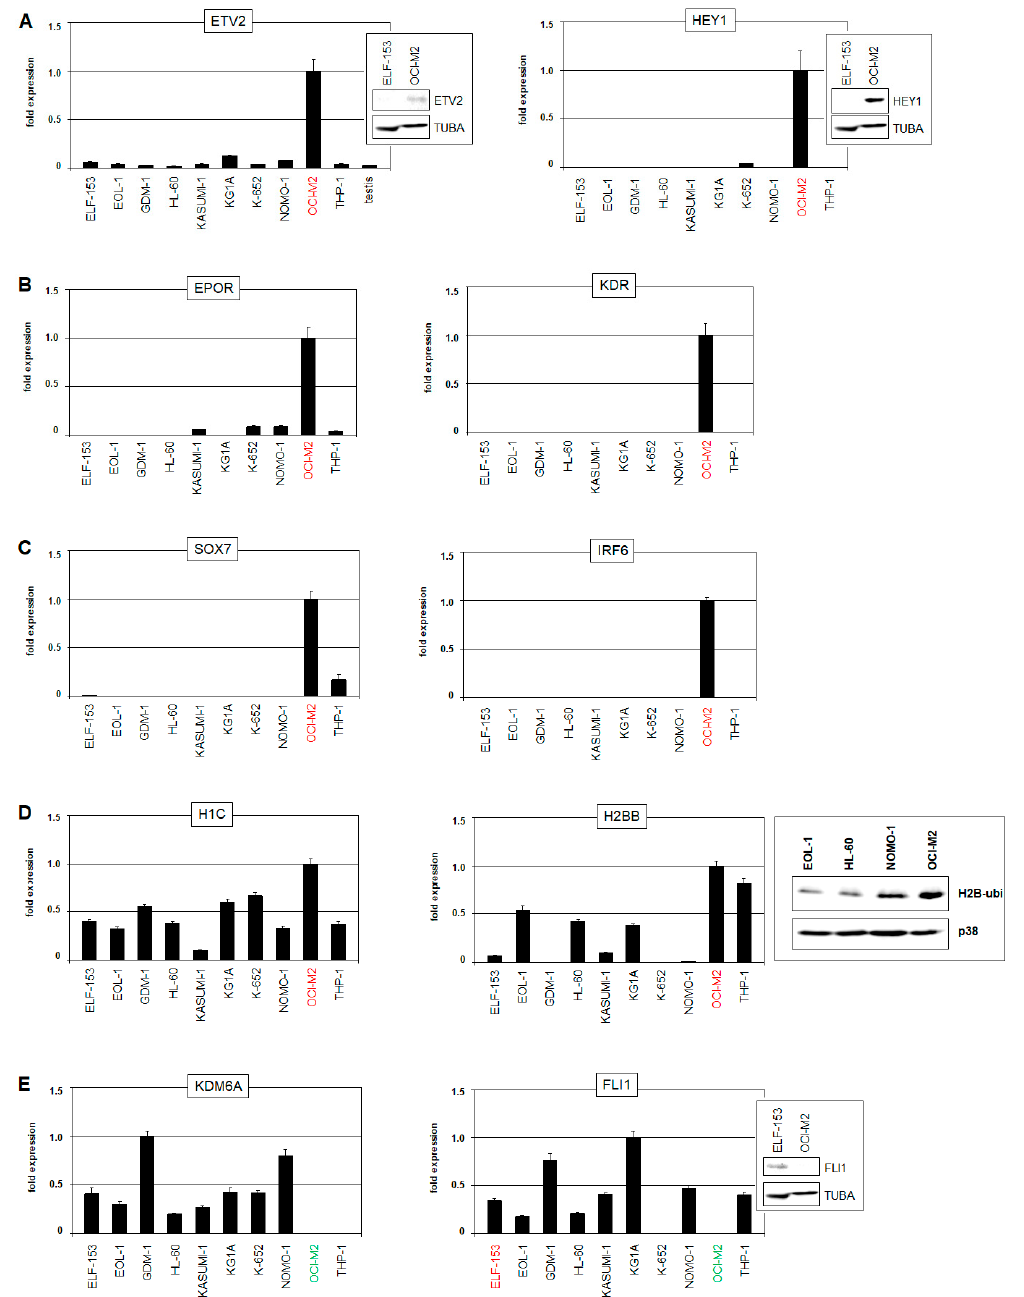
Figure 3. RQ-PCR and Western blot analysis of selected genes in AML cell lines. ( A ) RQ-PCR and Western blot analyses of ETV2 ( left ) and HEY1 ( right ) demonstrate elevated expression levels in OCI-M2. ( B ) RQ-PCR analyses of EPOR ( left ) and KDR ( right ) demonstrate increased expression levels in OCI-M2. ( C ) RQ-PCR analyses of SOX7 ( left ) and IRF6 ( right ) demonstrate elevated expression levels in OCI-M2. ( D ) RQ-PCR analyses of H1C ( left ) and H2BB ( middle ) demonstrate high expression levels in OCI-M2. Raised levels of ubiquinated H2B are shown by Western blot analysis, using p38 as loading control ( right ). ( E ) RQ-PCR and Western blot analyses of KDM6A ( left ) and FLI1 ( right ) demonstrate reduced expression levels in OCI-M2. The cell lines OCI-M2 and ELF-153 are indicated in red and green. The expression levels of OCI-M2 were set as 1, except for analyses of KDM6A (GDM-1 was set as 1) and FLI1 (KG1A was set as 1).